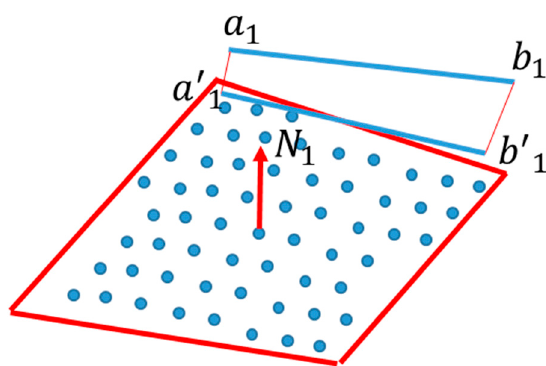
Figure 6. Projection of image feature line to the segmented plane. 𝑎 (cid:2869) 𝑏 (cid:2869) represents stereo forward intersection of matching lines. 𝑎 (cid:2869)(cid:4593) 𝑏 (cid:2869)(cid:4593) represents the result of projecting 𝑎 (cid:2869) 𝑏 (cid:2869) to the plane. 𝑁 (cid:2869) is the normal vector of the plane.